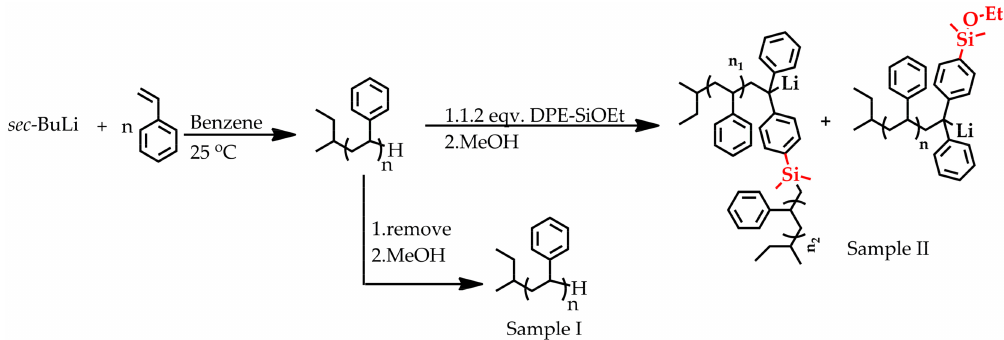
Figure 4. End-capping poly(styryl)lithium (PSLi) with DPE-SiOEt. First, sample I is removed from the solution. Then, PSLi is end-capped with DPE-SiOEt to afford sample II. (Design M n = 2 kg/mol).